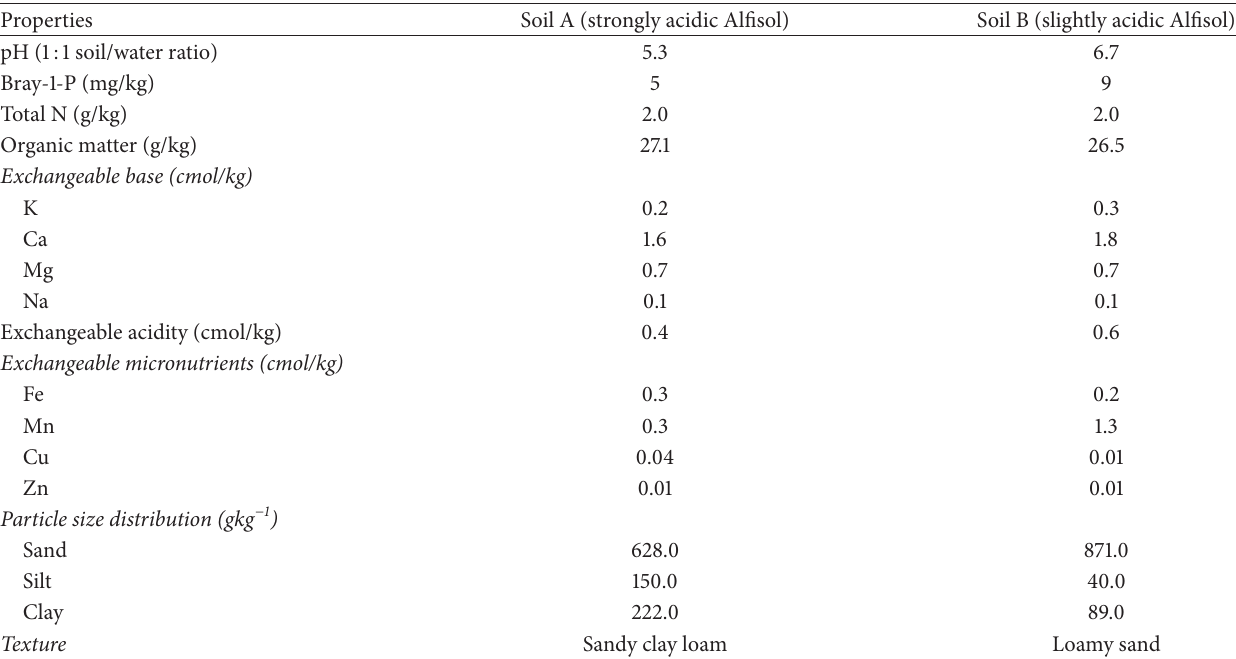
Table 1: Precropping chemical and particle size analysis of the soils used in the